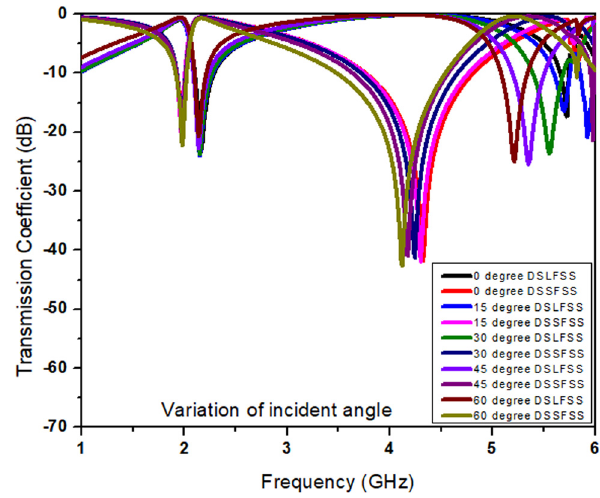
Figure 8: Transmission coe ffi cient of the CPFSS structure at di ff erent incidence angles ( DSLFSS shows transmission while DSSFSS shows re fl ection )